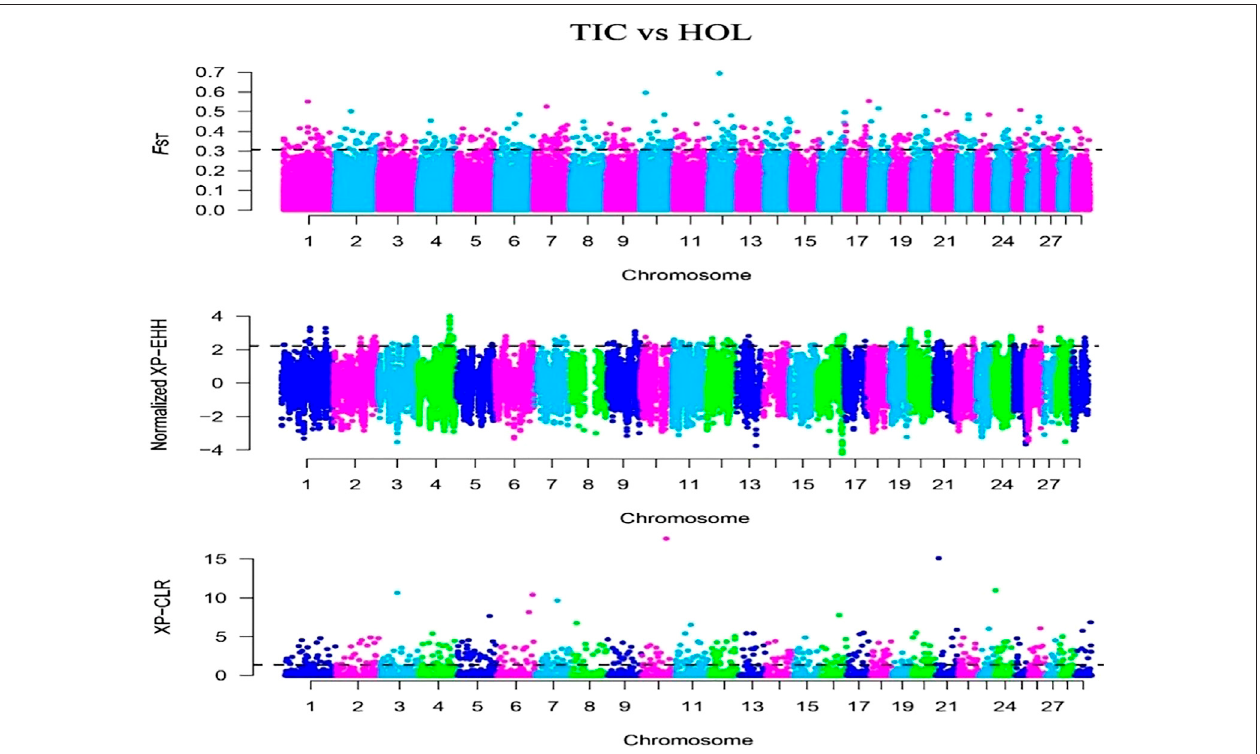
FIGURE4| Genome-widedistributionof F ST ,XP-EHH,andXP-CLRofTibetancattlevs.Holsteinonautosomes.Thehorizontalblacklineinthegraphindicatesthe values of the top 1%.